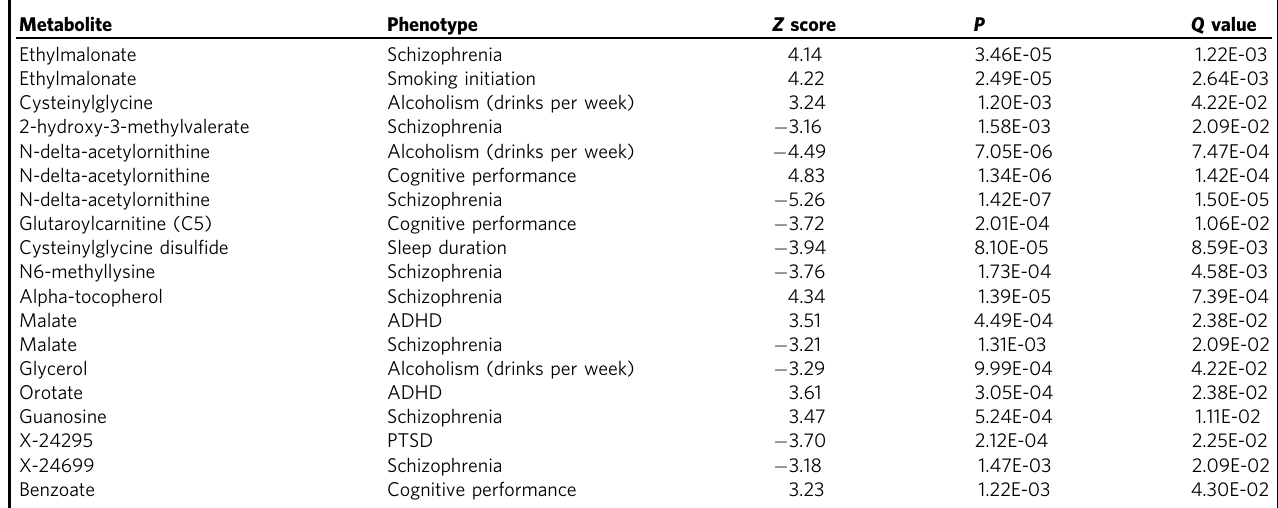
Table 1 Signi fi cant CSF metabolite – phenotype associations from